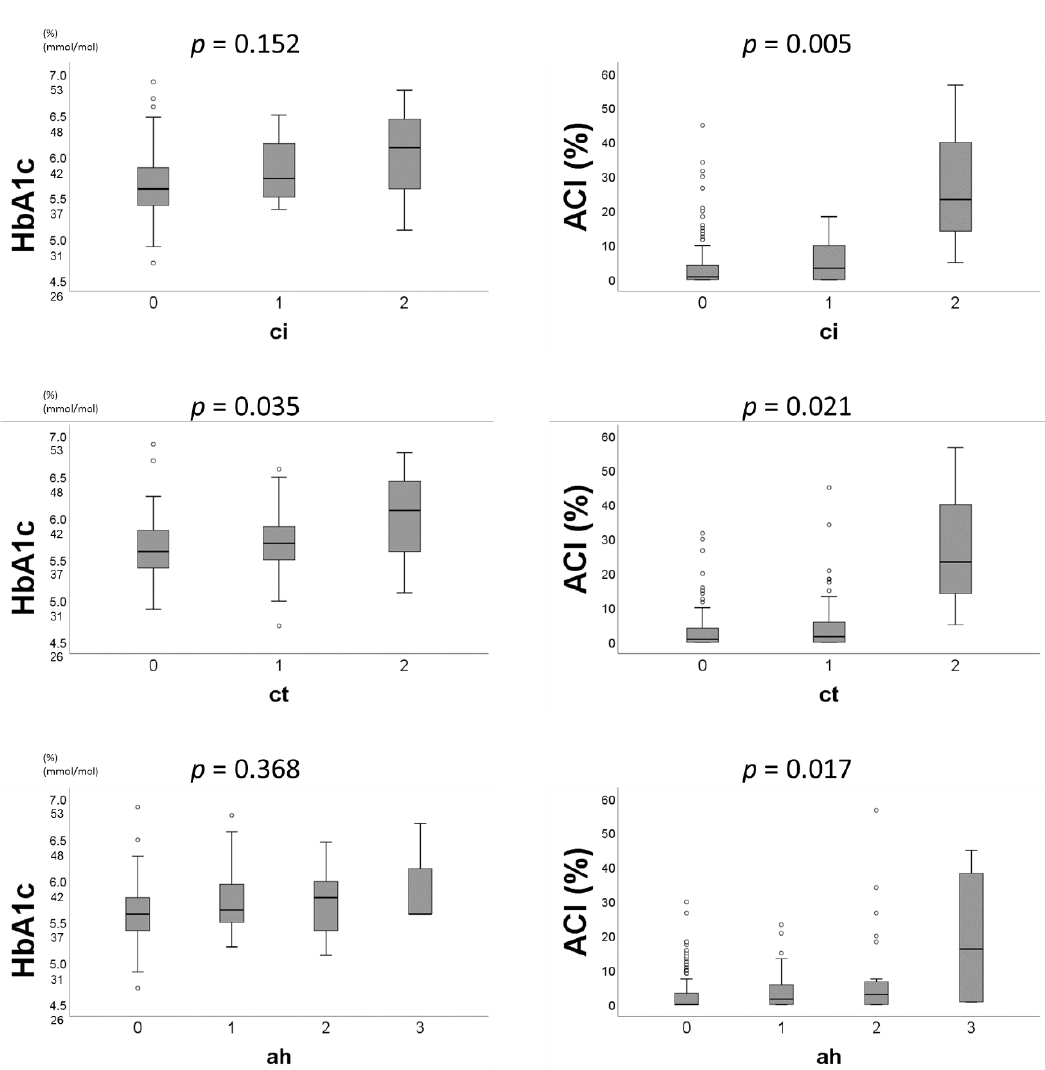
Figure 3. The distribution of HbA1c and ACI by ci, ct, and ah score. HbA1c: hemoglobin A1c. ACI: abdominal calcification index. ci: interstitial fibrosis. ct: tubular atrophy. ah: arteriolar hyalinosis.